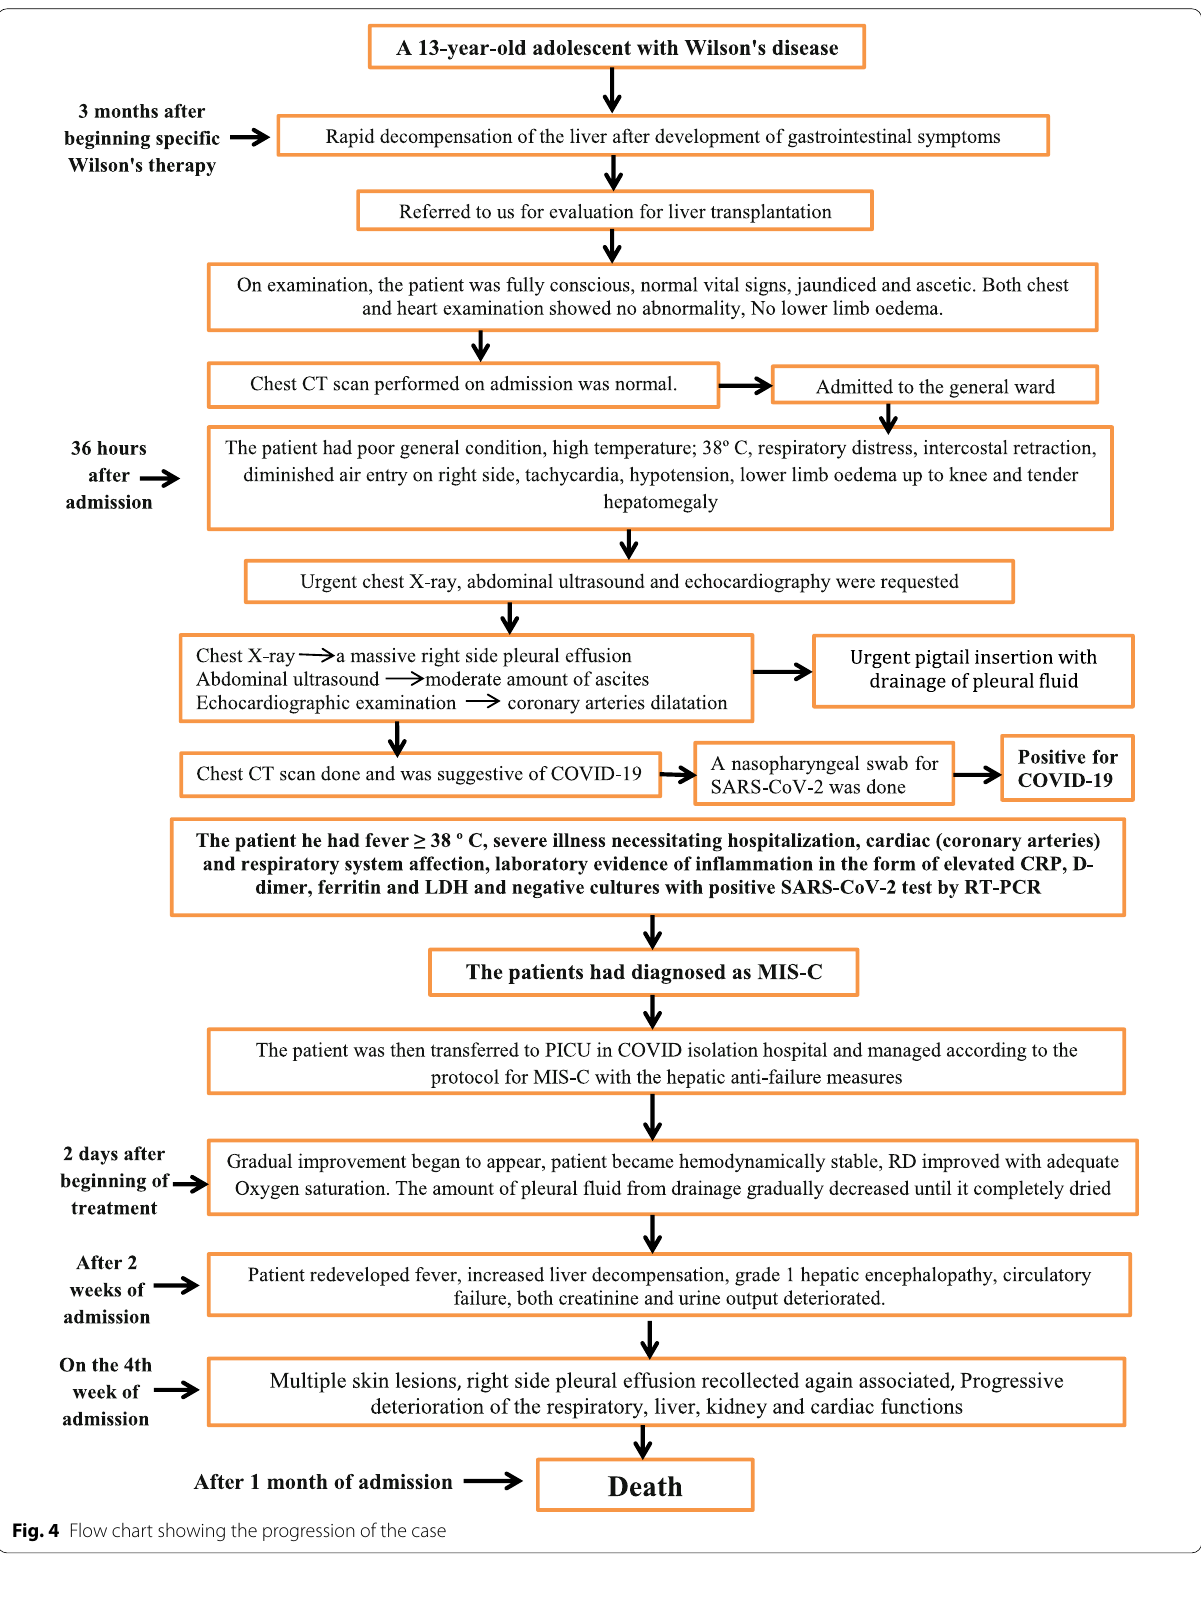
Fig. 4 Flow chart showing the progression of the